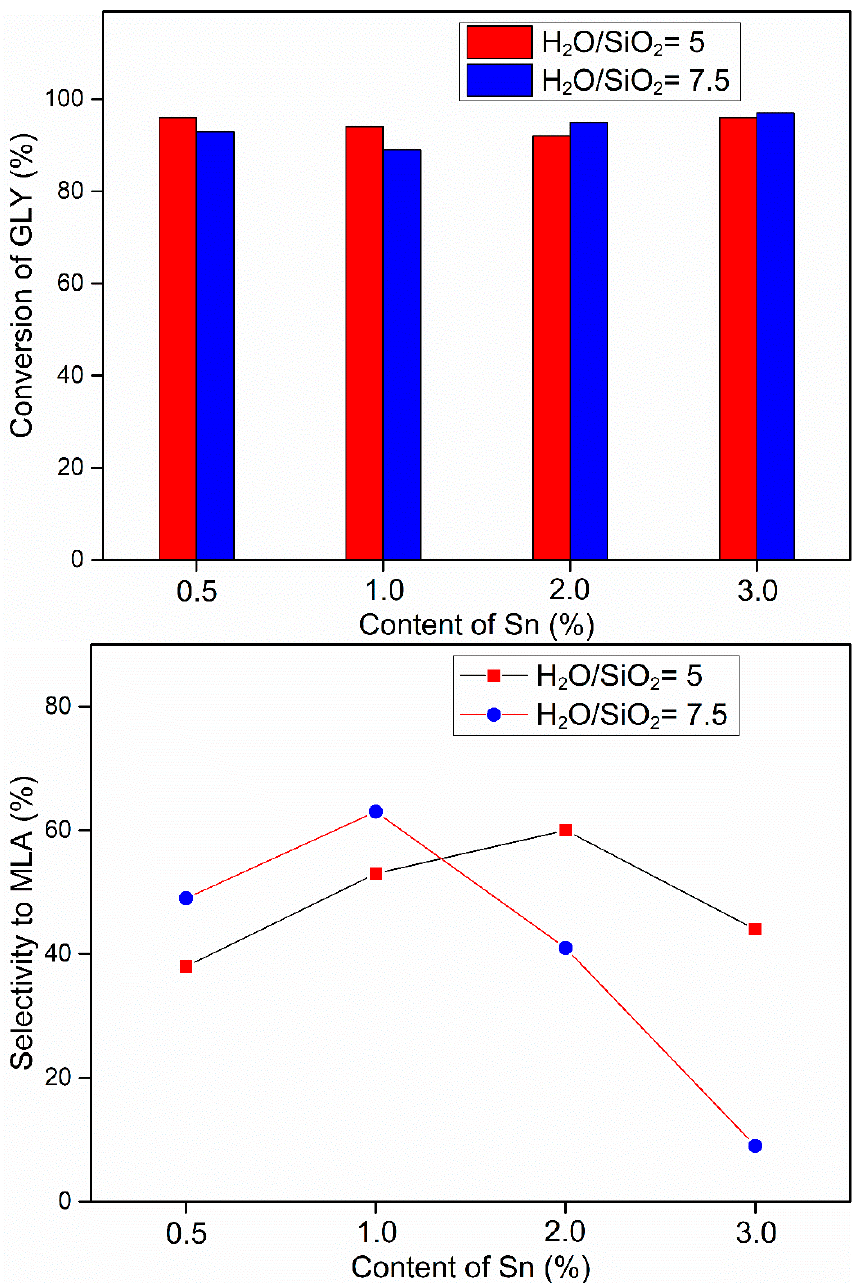
Figure 6. The GLY oxidation using Sn- β prepared with different content of H 2 O.